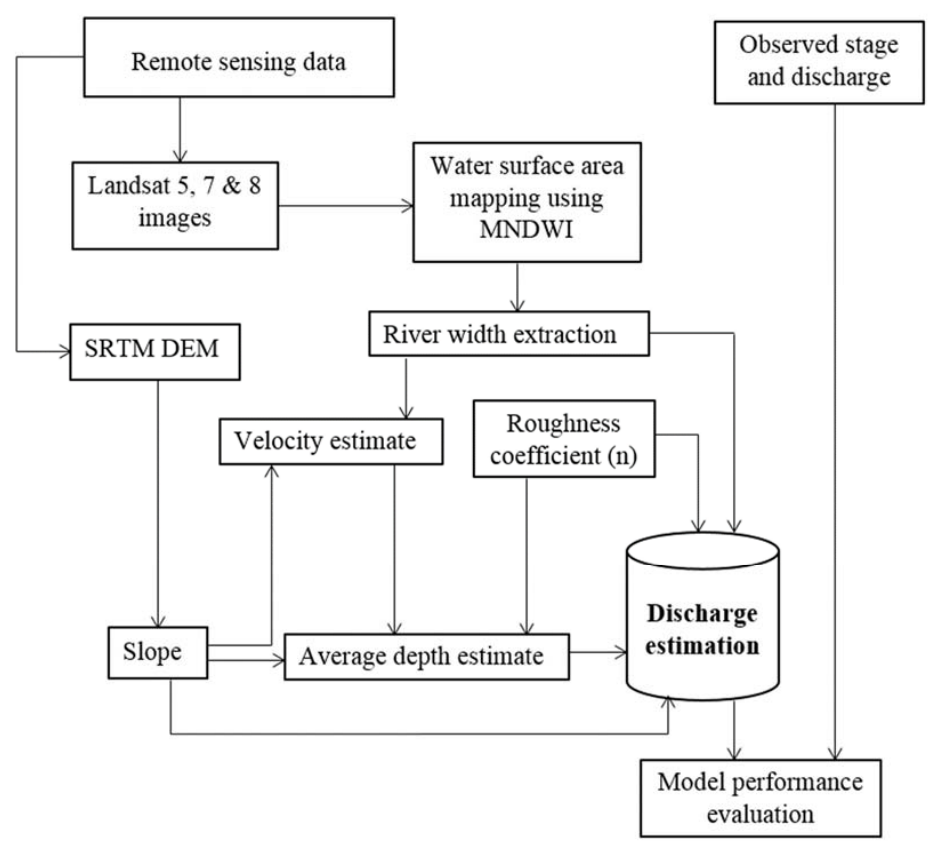
Figure 3. A flowchart showing how to derive the hydraulic parameters from remote sensing for river discharge estimation using Equation (6) and Equation (7).